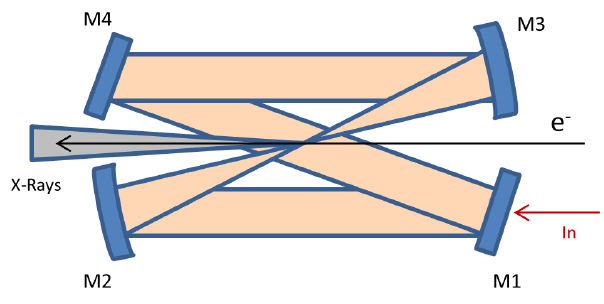
Figure 9. Scheme of the 4-mirrors bow-tie